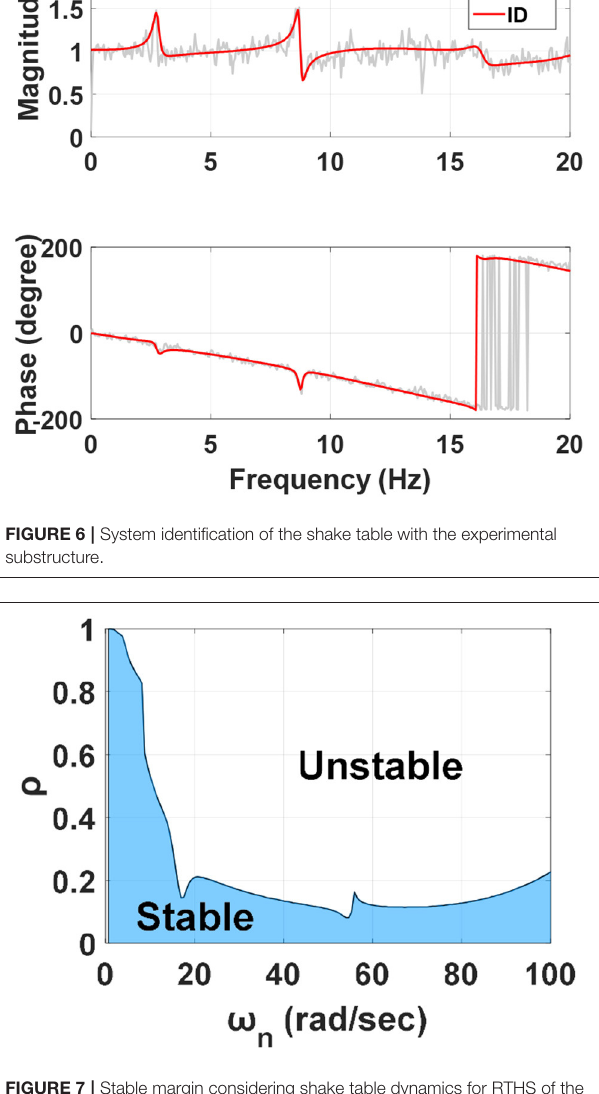
FIGURE 7 | Stable margin considering shake table dynamics for RTHS of the 8-story BMD